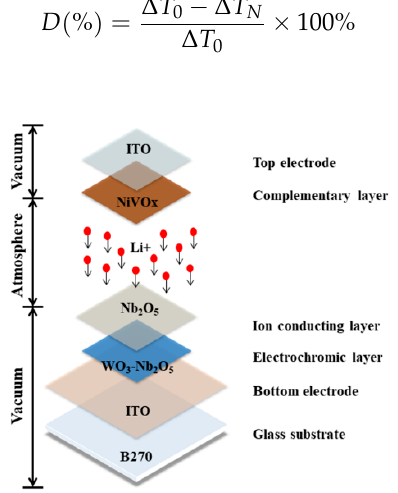
Figure 12. Layered monolithic structure of the all-solid-state electrochromic device (ASSECD) constructed.